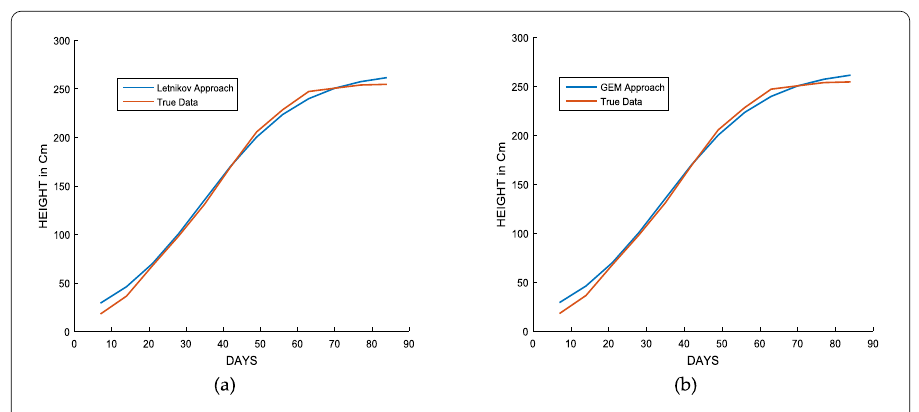
Figure 3 Graphs of ( a ) PSE with q = 1 and ( b ) GEM for q = 1